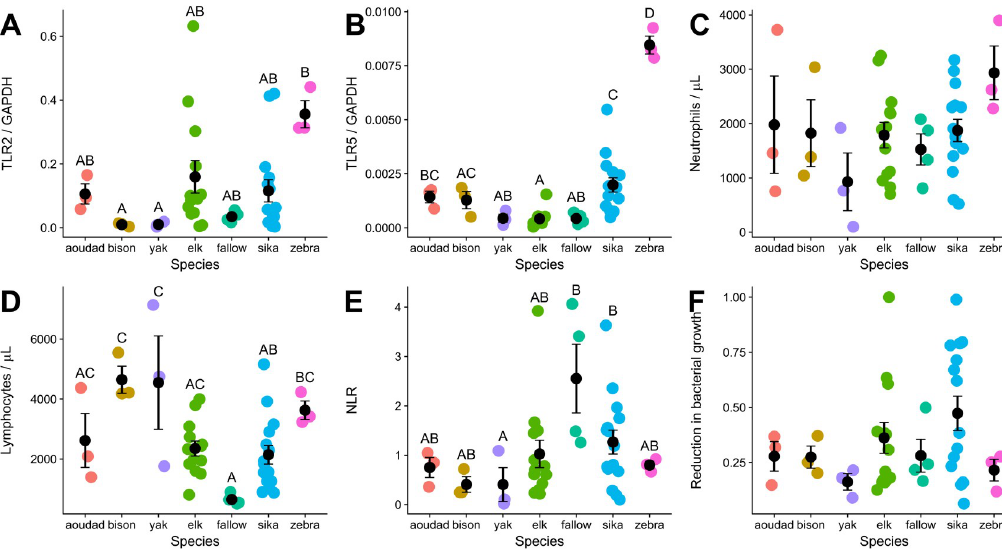
Fig 1. Variation in innate immune parameters among ungulate species. Each data point represents an individual animal with points color-coded by species at Wildlife Safari (2013–2014). Black points and bars represent the average and standard error for each species. Significant pairwise differences are denoted by letters above each bar. Toll-like receptor 2 (TLR2, A), Toll-like receptor 5 (TLR5, B), lymphocytes (D), and neutrophil to lymphocyte ratio (NLR) (E) were significantly different between some species. Neutrophils (C) and the bacterial killing assay (BKA) (F) were not significantly different between